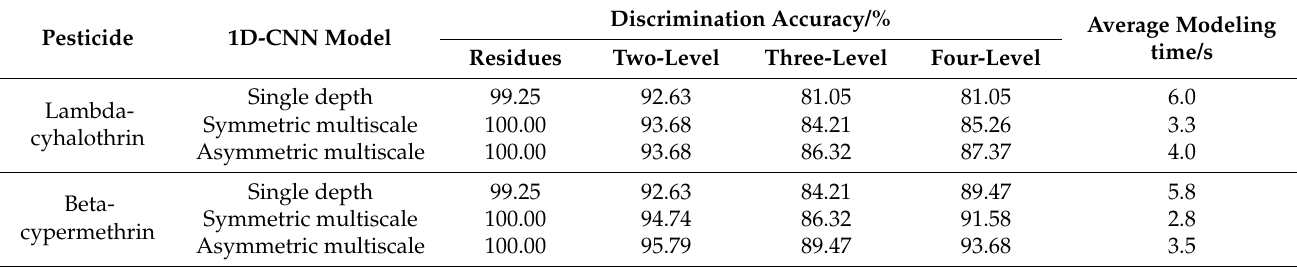
Table 6. Results of different models for the discrimination of pesticide residue levels on the Hami melon surface.